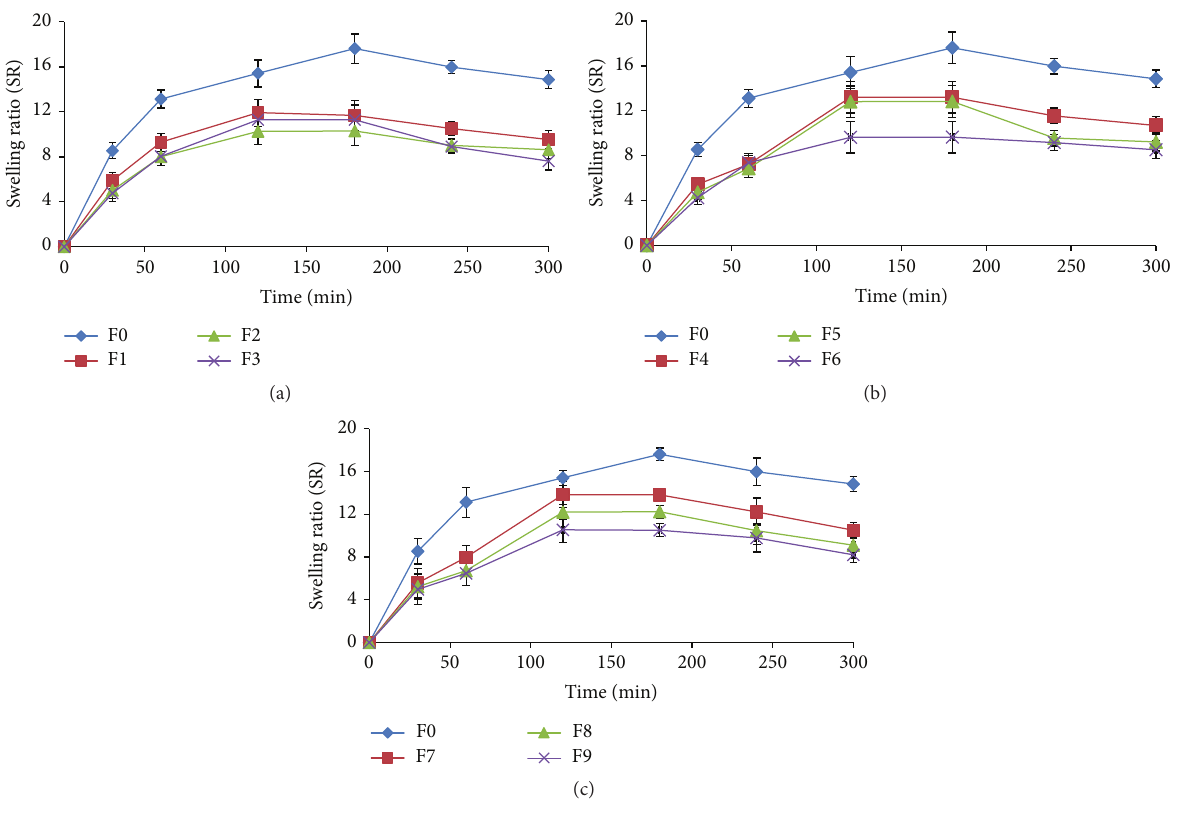
gradually. Obtained curves showed an initial rapid increase within 30 min of the experiment due to the entry of water via metastable pores known as hysteresis of swelling mechanism and reached the highest value after 120 min for formulations F1–F9 and after 180 min for microspheres placebo. Formu- swelling ratio, while microspheres F6 (with the highest MF loading) attained lower value of SR. Swelling in acidic pH as a result of osmosis caused by unbound carboxyl